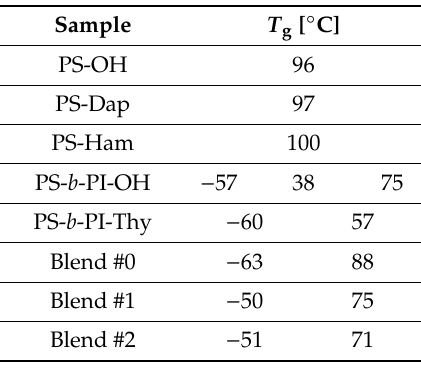
Table 6. DSC results for the end-functionalized polymers and